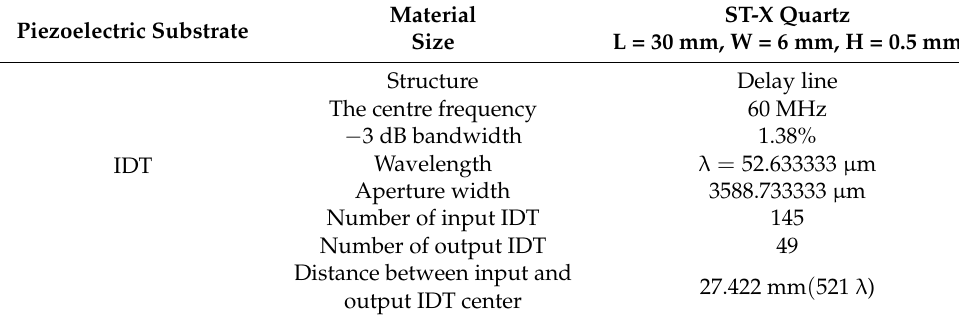
Table 2. Design parameters of SAW delay